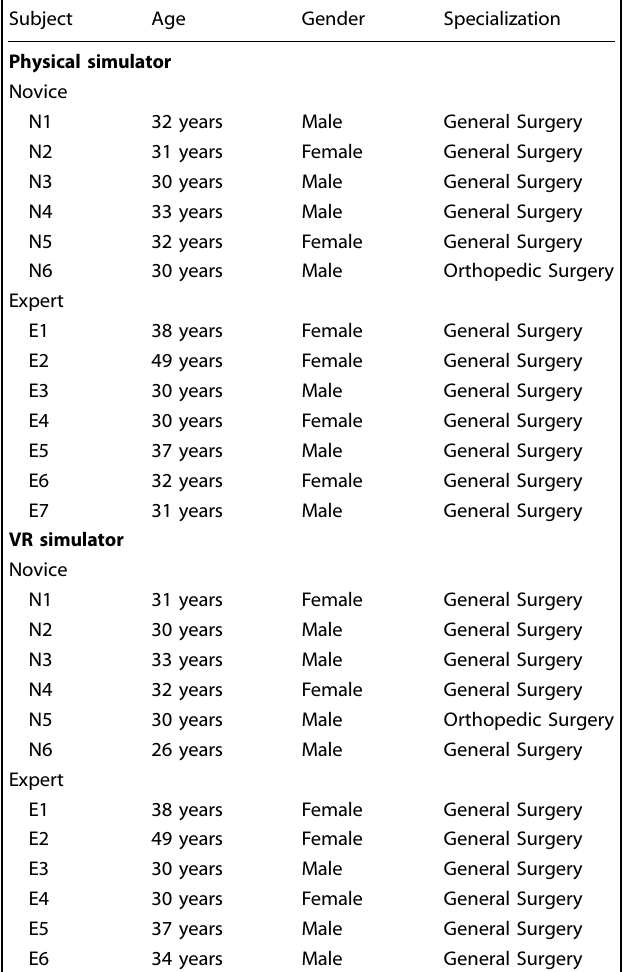
obstruct the free movement of the participant during the FLS task performance. fNIRS data processing for the oxyhemoglobin time